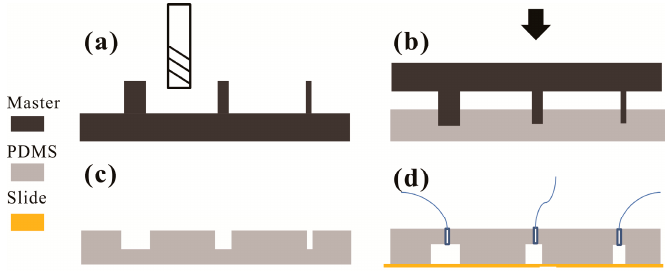
Figure 1. Schematic illustration of polydimethylsiloxane (PDMS)-based microchannel fabrication based on replica positive master created using a milling technique. ( a ) The positive master is mechanically milled in an acrylic block; ( b ) The positive micropatterns are inserted into pre-cured PDMS agent; ( c ) The solidified PDMS block is peeled off the master; ( d ) The PDMS block is bonded onto a glass plate by O 2 plasma treatment.